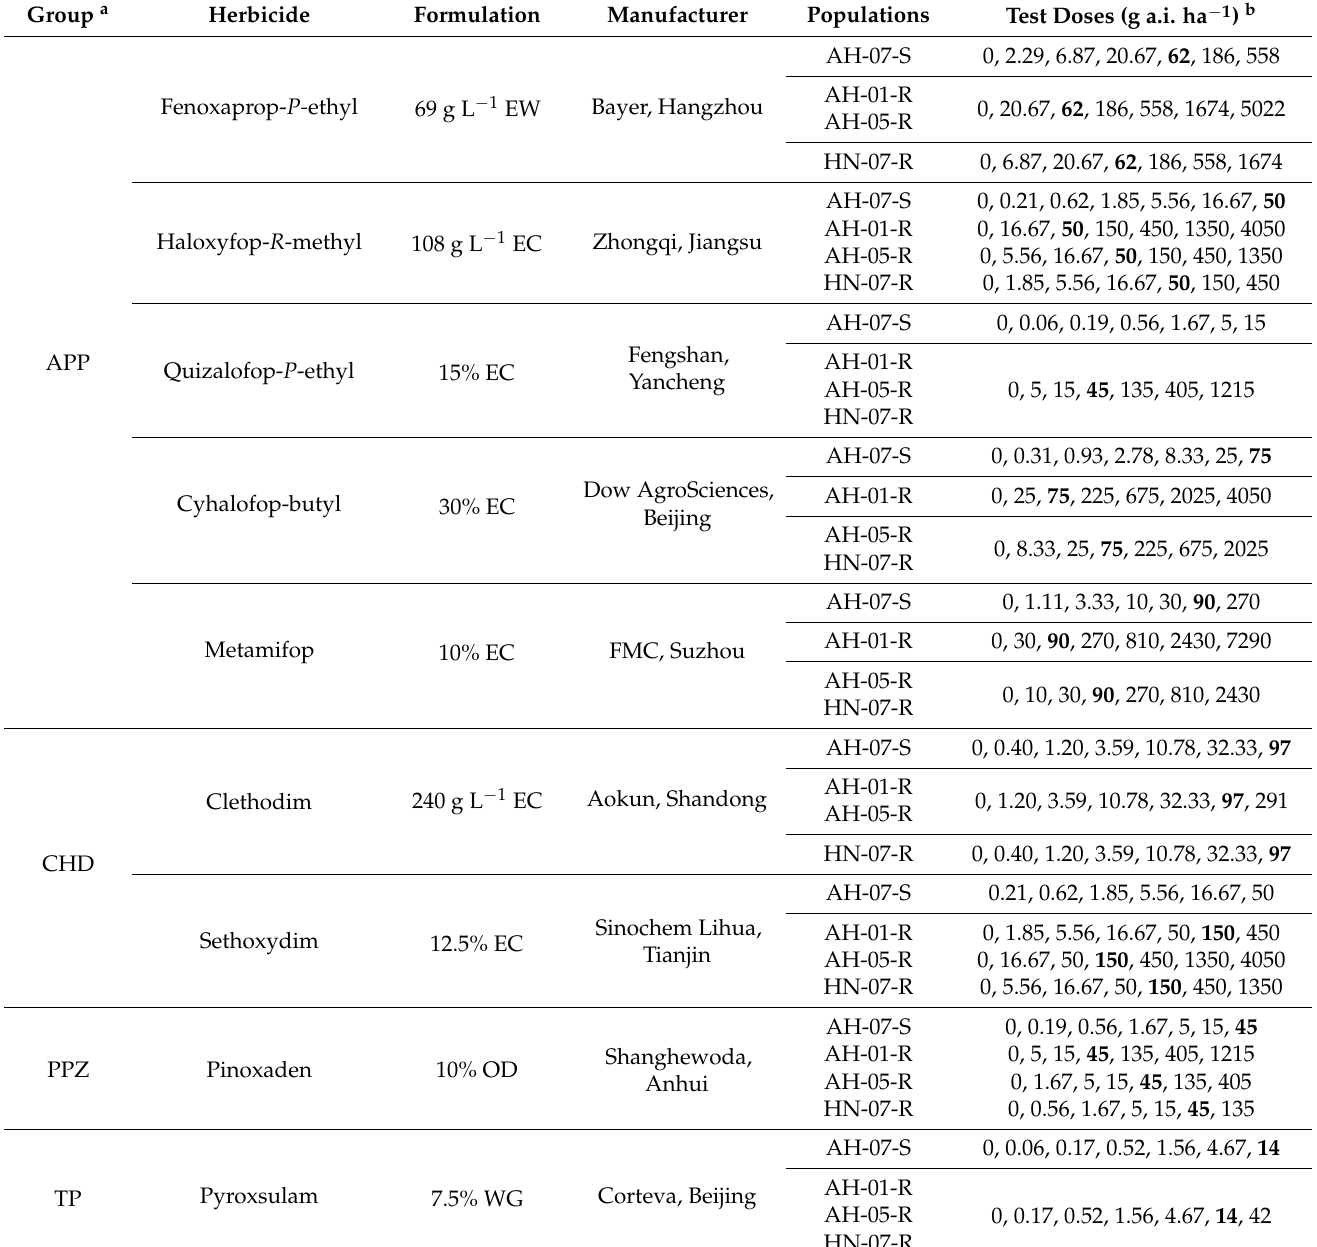
Table 4. Herbicides and their doses used in cross- and multiple- resistance experiments for different L. multiflorum